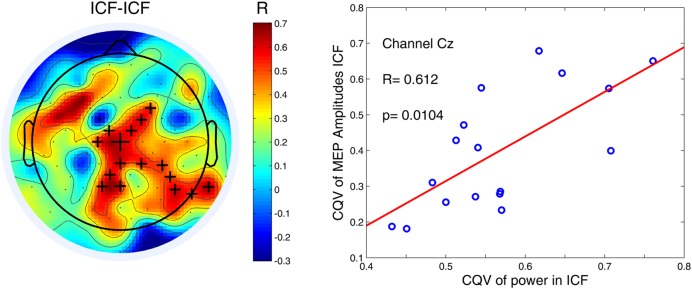
Variability of high-alpha (10–12 Hz) power in the 1000-ms time window for ICF condition was positively correlated with variability of MEP amplitudes. Black crosses indicate channels that belong to a significant cluster (P < 0.05). An exemplary scatter plot is given for one of the channels (denoted by the largest cross) from a significant cluster.